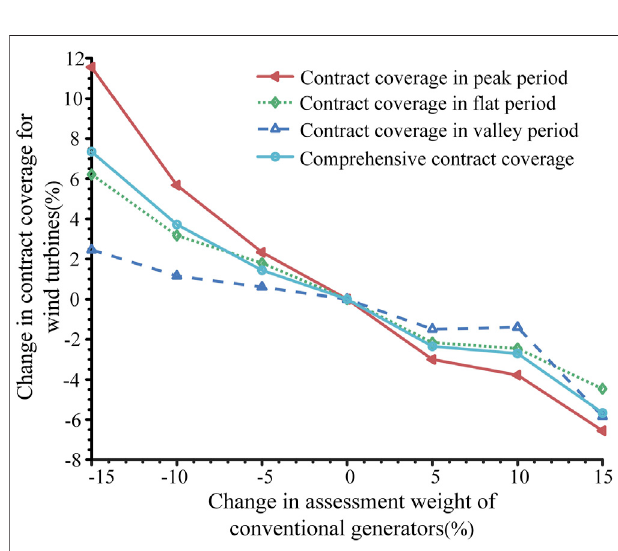
FIGURE 7 | Changes in CCR of wind turbines under different assessment weights of the quota